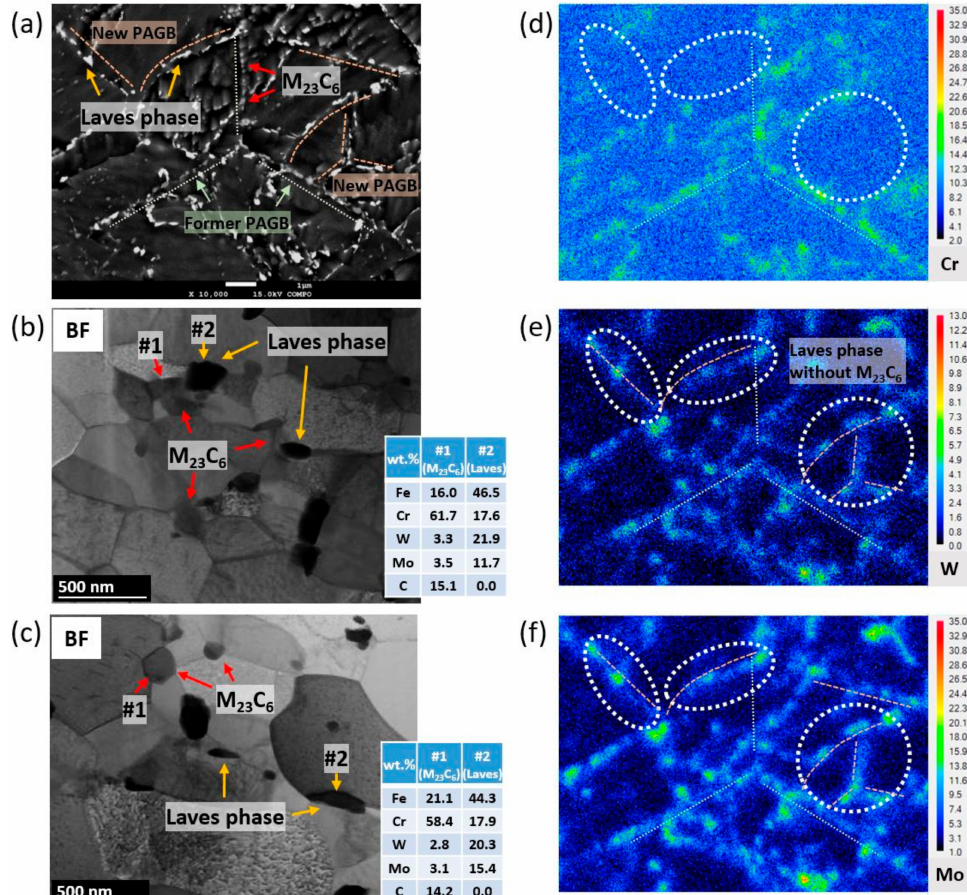
Figure 7. SEM, TEM, and EPMA analysis of as-welded ICHAZ after creep test at 600 ◦ C/200 MPa: ( a ) SEM/BSE image; ( b , c ) TEM bright field image (including EDS analysis of the precipitates marked with arrows); and ( d – f ) EPMA elemental maps for Cr, W, and Mo,